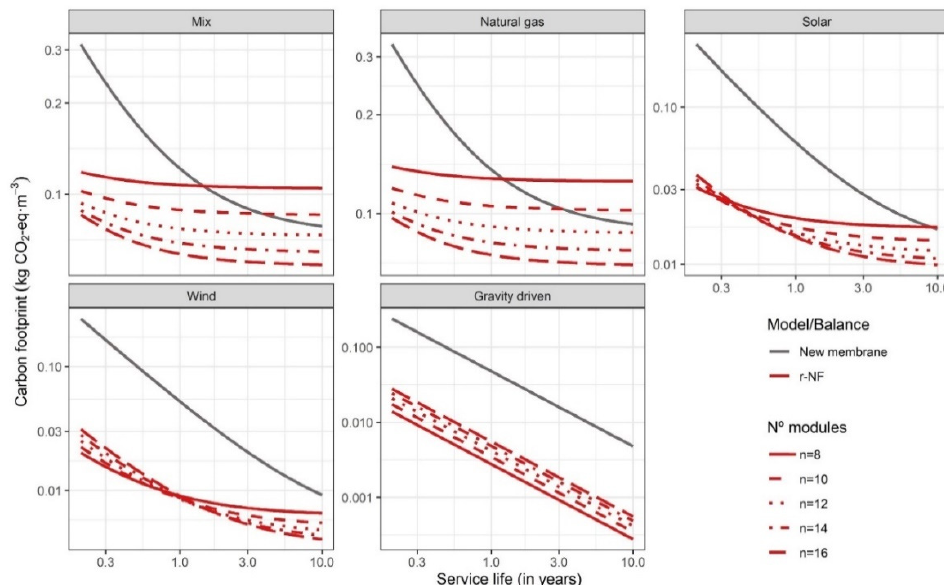
Figure 3. Carbon footprint depending on PV design and membrane lifespan with strategy B. Conditions: Q in = 4 m 3 ·h − 1 and WR = 50%.